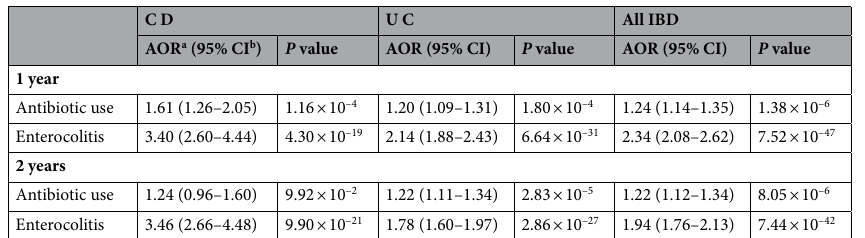
Table 2. AORs and 95% CIs using conditional logistic regression analysis for CD, UC, and all IBD (CD and UC combined). a Adjusted odds ratio. b Confidence interval.